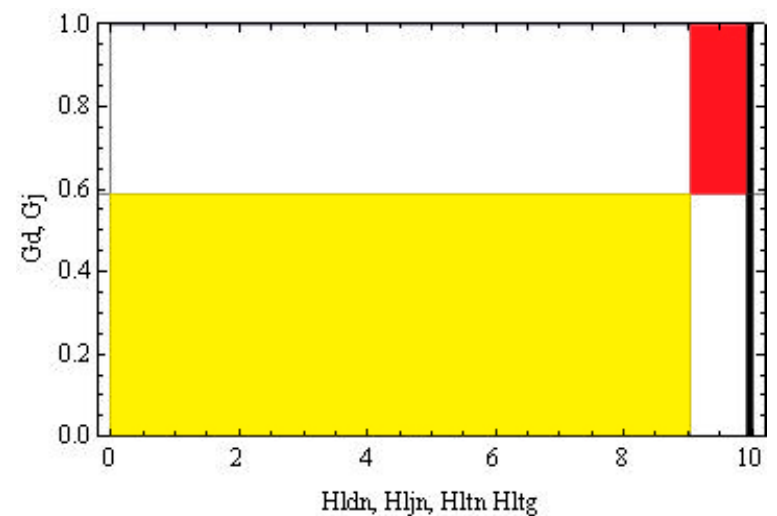
Figure 6. Characterization of a representative intradisciplinary and intratopical heterodox PH. Black area (0.9%) = networking; red area (3.6%) = intradisciplinary and intratopical heterodox; yellow area (53.8%) = intradisciplinary and intertopical orthodox; blue area (0%) = interdisciplinary and intertopical orthodox. G d = 0, G j = 0.59, H ldn = 2.11, H ljn = 9.04, H ltn = 9.91, H ltg = 10.00. Abbreviations: G d , Gini index for disciplines; G j , Gini index for journals; H , Hirsch indexes; d = discipline, g = gross, j = journal, l = linear, n = net, t = total. Publications 2018 , 6 , x FOR PEER REVIEW 17 of 29